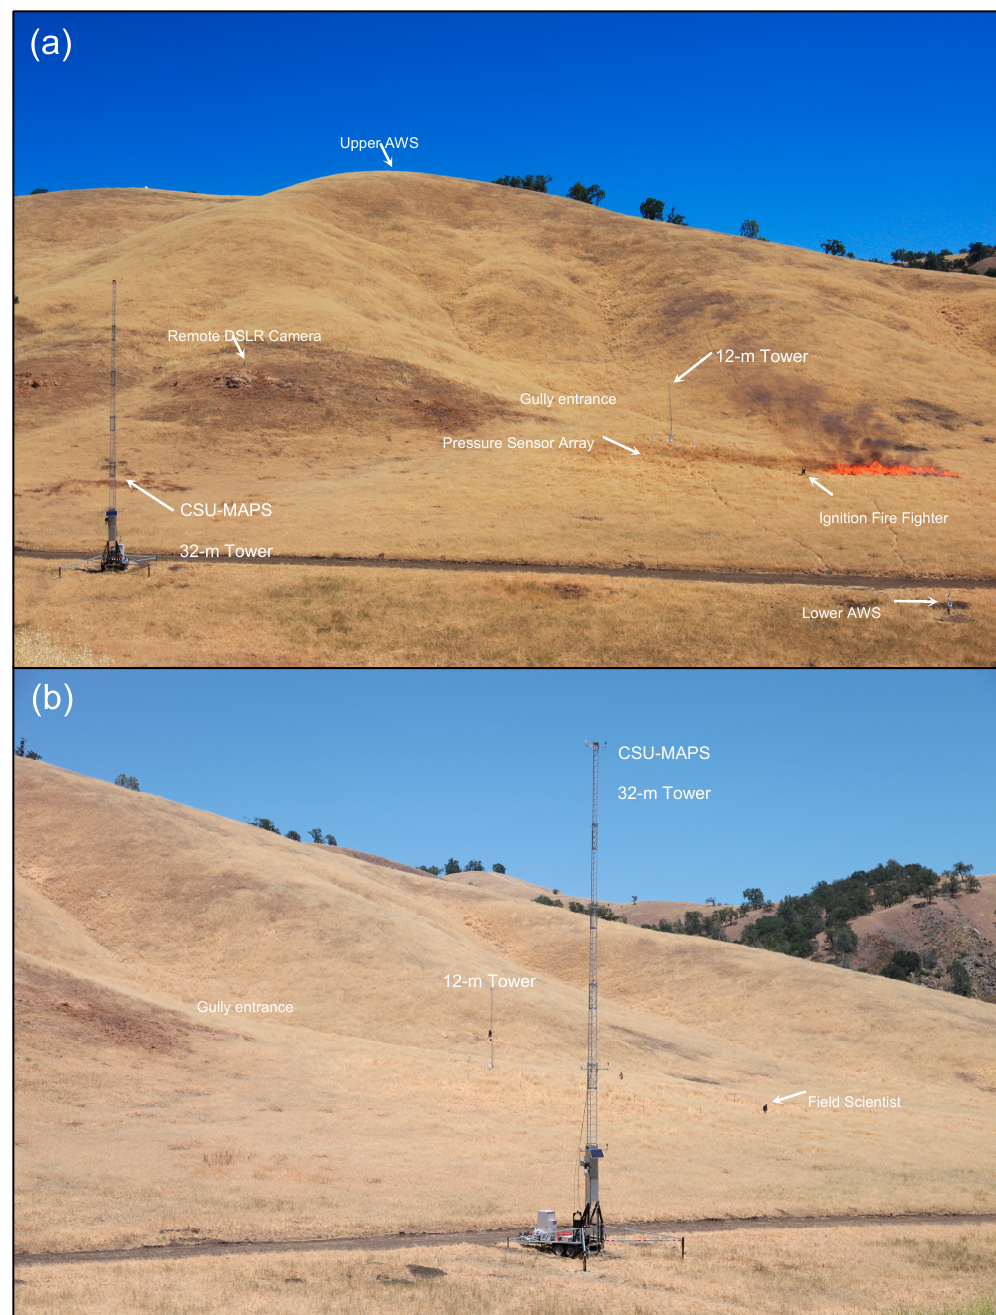
Figure 2. Photographs showing experimental plot and some key instrument platforms. ( a ) Photograph taken during ignition from lidar site, ( b ) photograph of site taken during instrument installation from southwest of the burn plot. Please refer to Figure 1 for plot